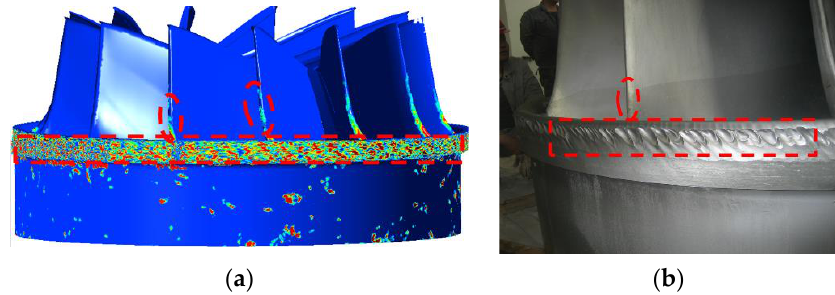
Figure 4. Erosion at the inlet of the stay guide vane. ( a ) CFD result; ( b ) Wear physical